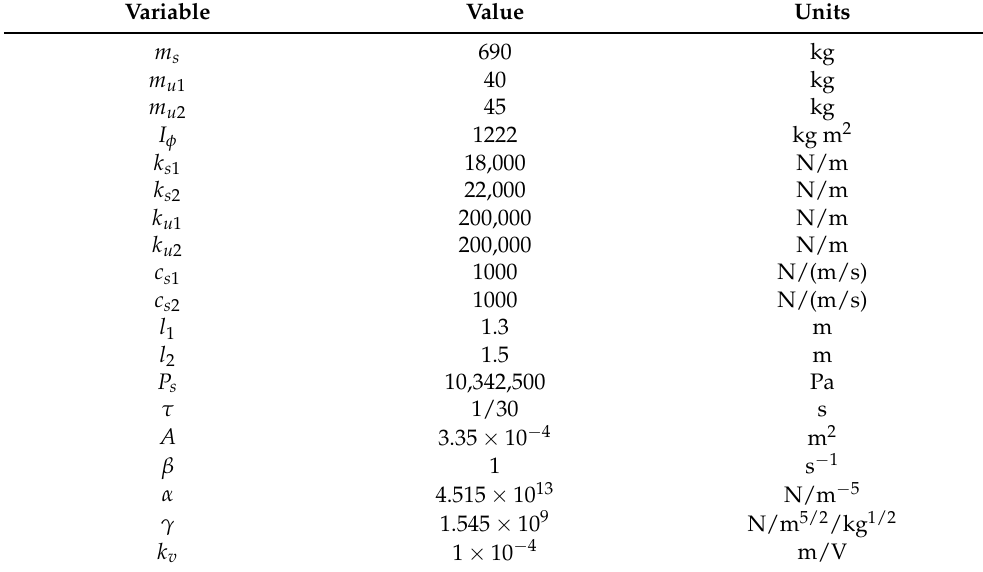
Table 1. Constant Values of the Active Suspension